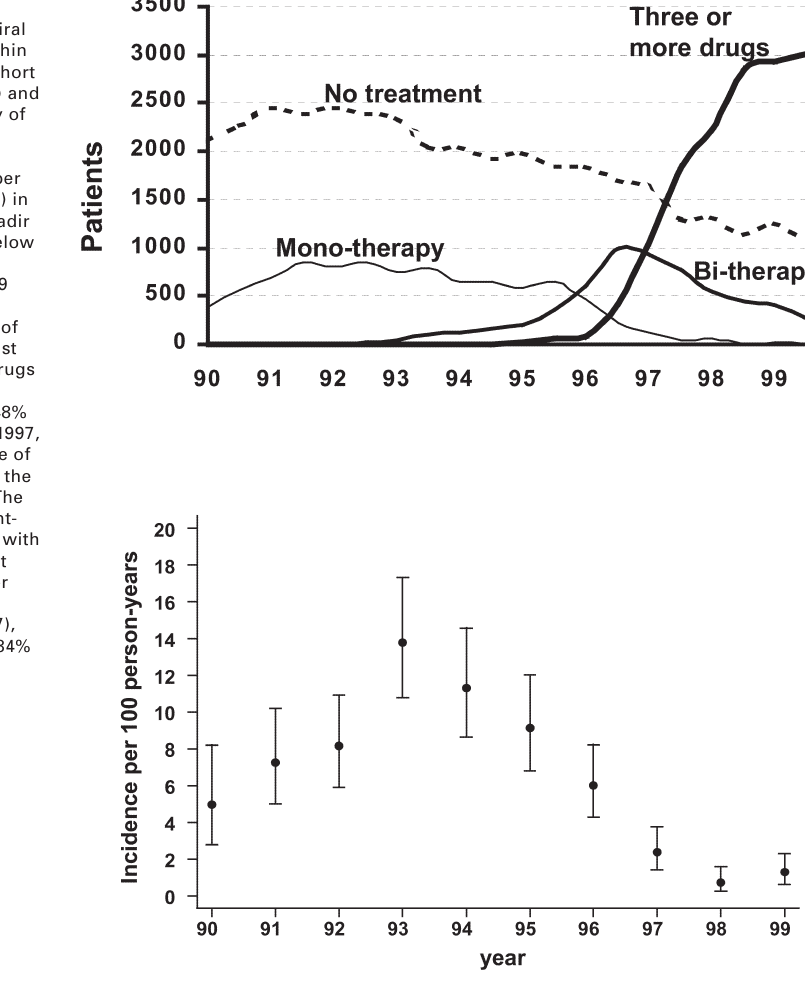
Use of antiretroviral drug regimes within the Swiss HIV Cohort Study (top panel) and incidence density of disseminated M. avium Complex infection (cases